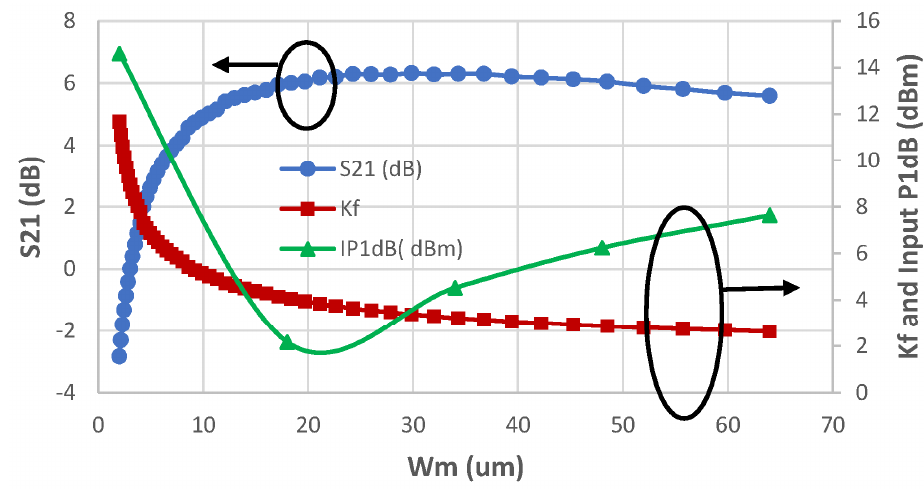
Figure 7. Gain and Input P1dB versus DC current source.